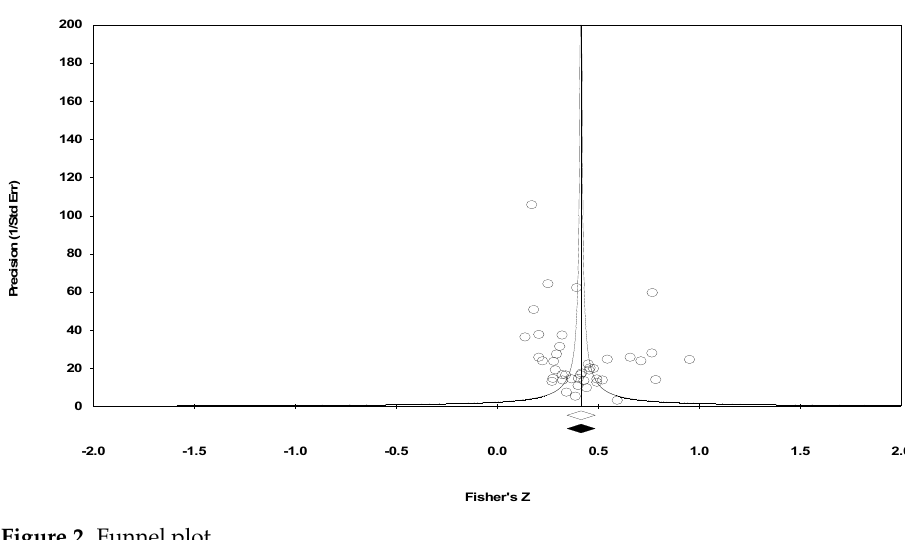
Figure 2. Funnel plot.